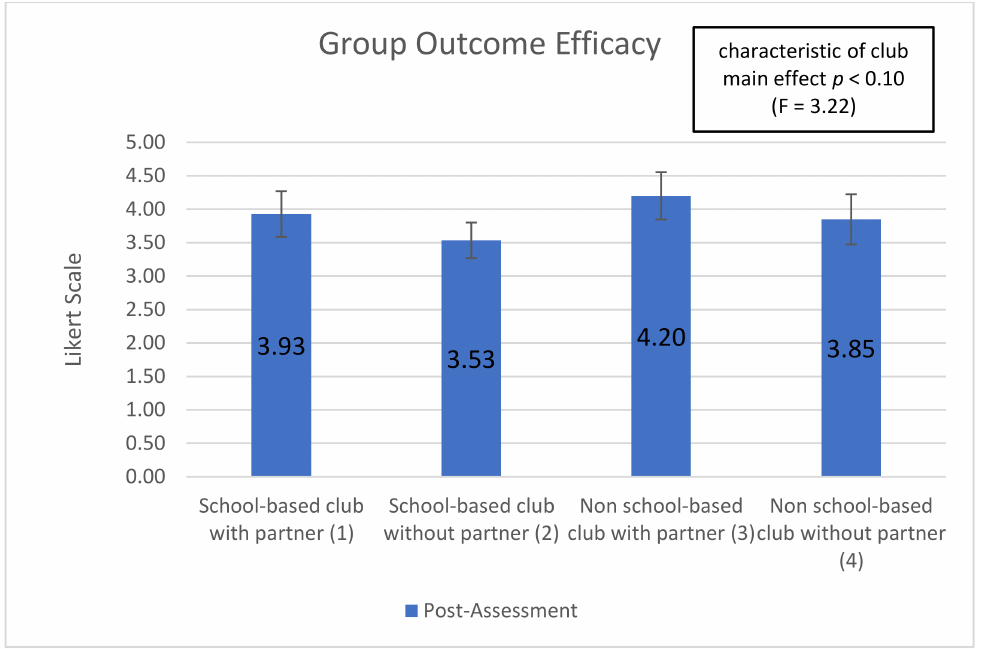
Figure 6. Group Outcome Efficacy post-assessment by club type and